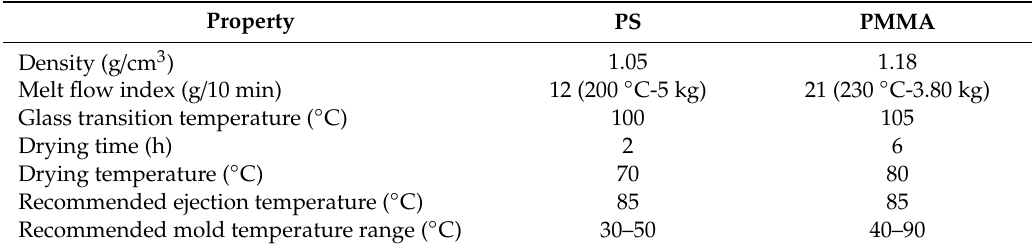
Table 3. Main properties of the selected polymers.